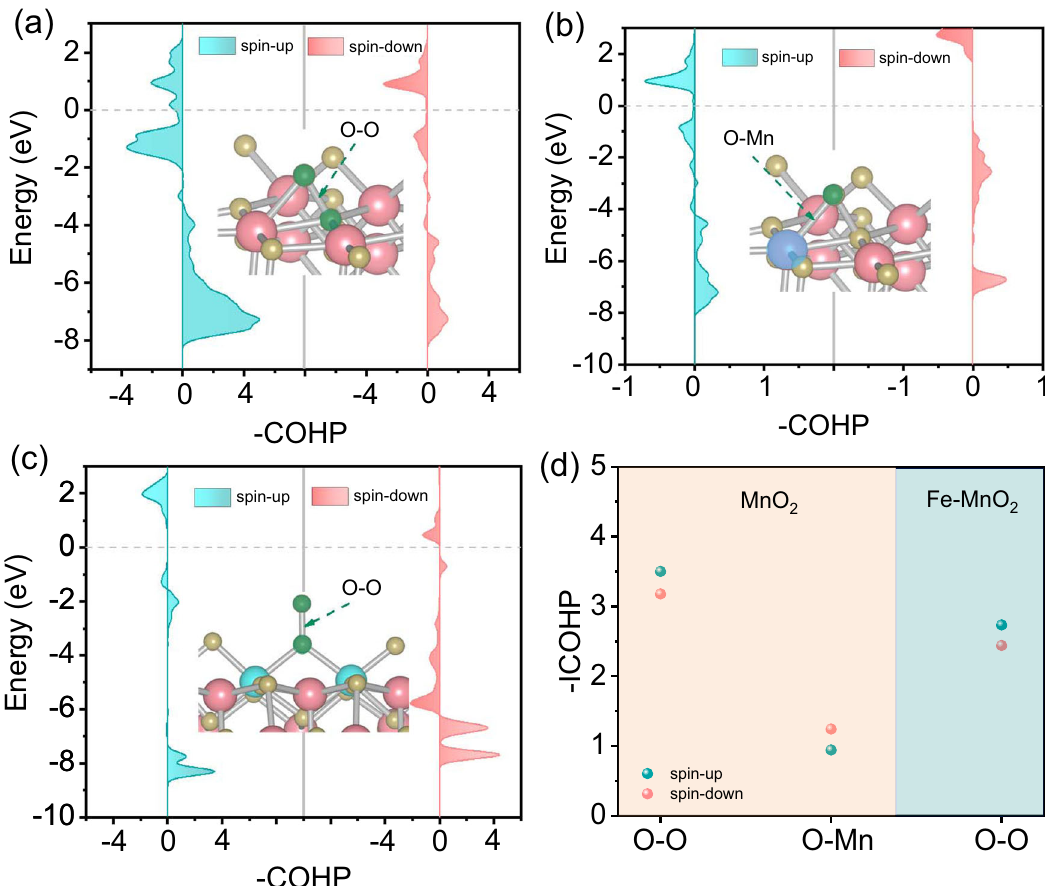
Fig. 4 Analysis of bonding strength. COHP of MnO 2 ( a , b ) and Fe/MnO 2 ( c ) at different positions. d The corresponding ICOHP in a – c . The insets in a – c show the corresponding